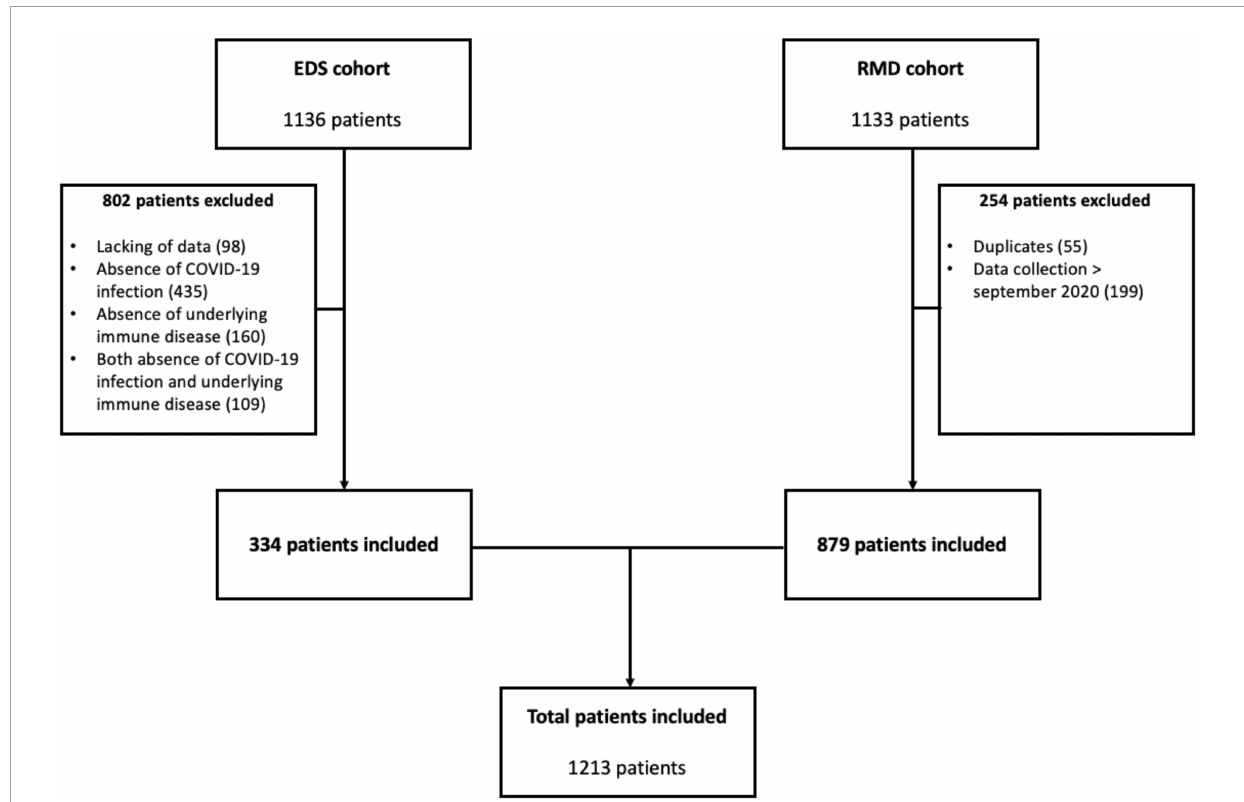
FIGURE1 Flow chart of patient inclusion. EDS, Entrepôt des Données de Santé; RMD, rheumatic and musculoskeletal